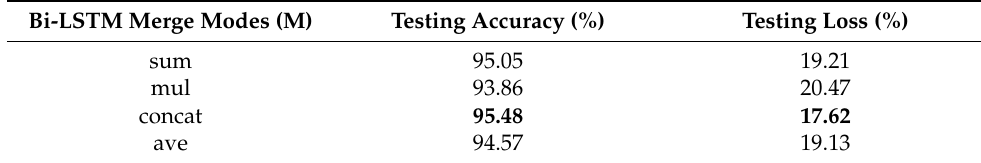
Table 5. Testing Aaccuracy and loss of different BiLSTM merge modes (O = SGDM, B = 64). Bi-LSTM Merge Modes